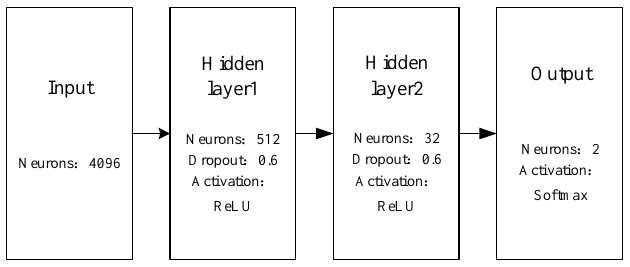
Figure 4. Neural network classification model.